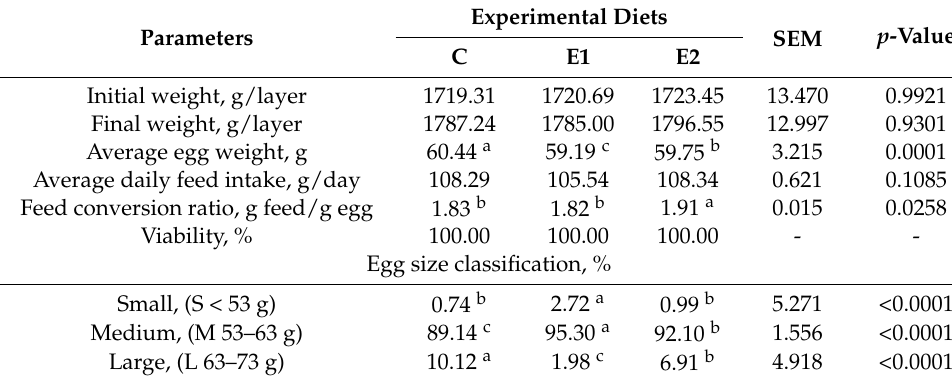
Table 6. The effect of experimental diets on laying hen performance.